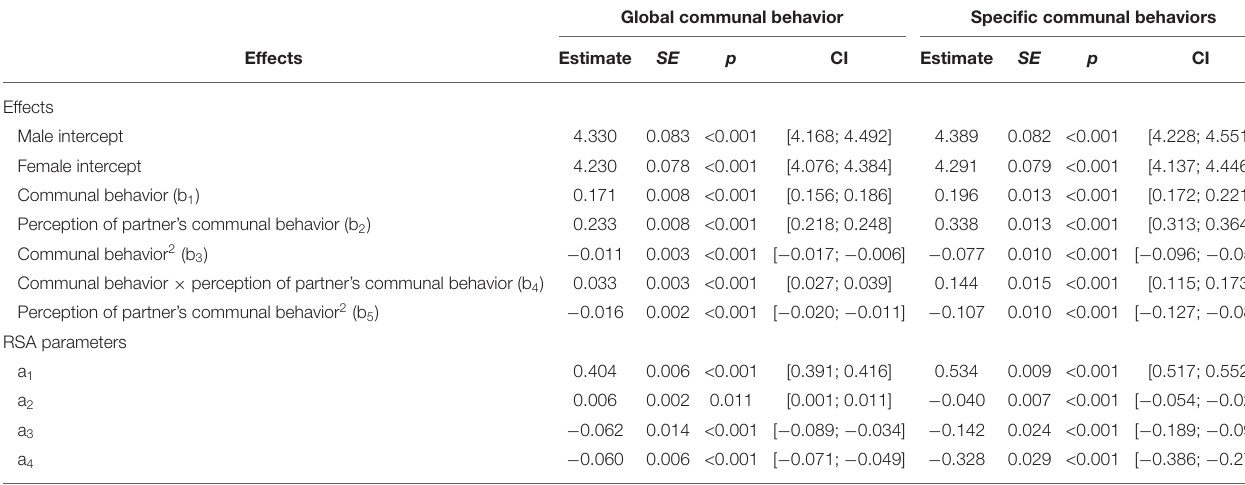
TABLE 4 | Results of multilevel response surface analyses for the prediction of communal need satisfaction by communal behavior and perceptions of the partner’s communal behavior.